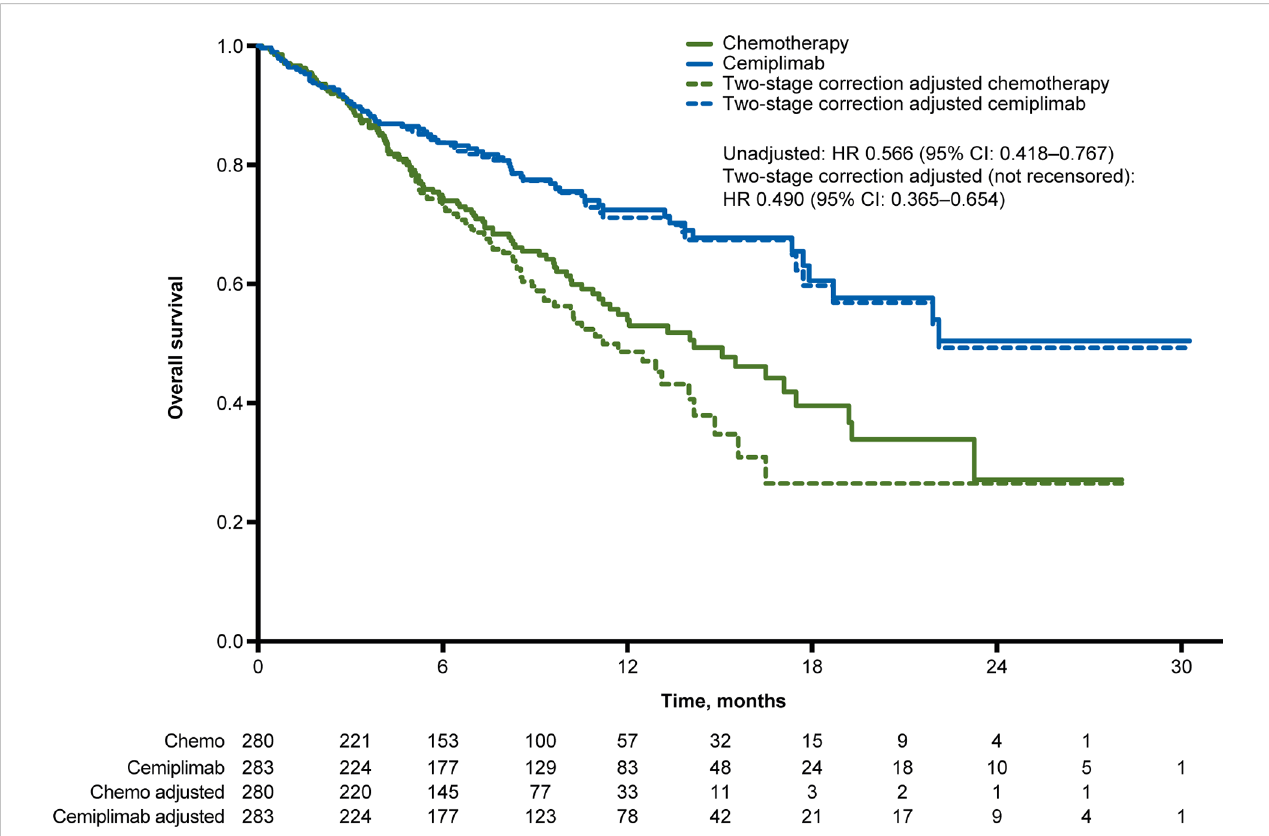
FIGURE 2 Overall survival Kaplan-Meier curves for the unadjusted and crossover-adjusted results from the EMPOWER-Lung 1 PD-L1 ≥ 50% population based on simpli fi ed two-stage correction. Values under the fi gure represent number of patients at risk. Chemo, chemotherapy; CI, con fi dence interval; HR, hazard ratio; PD-L1, programmed cell death-ligand